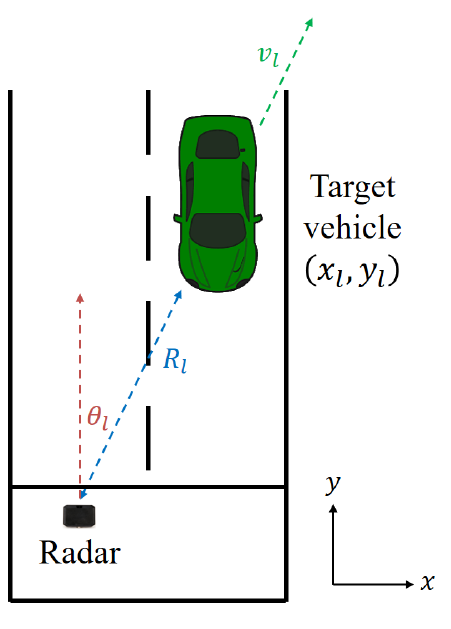
Figure 6. Method of estimating the position of the target using the radar detection result.